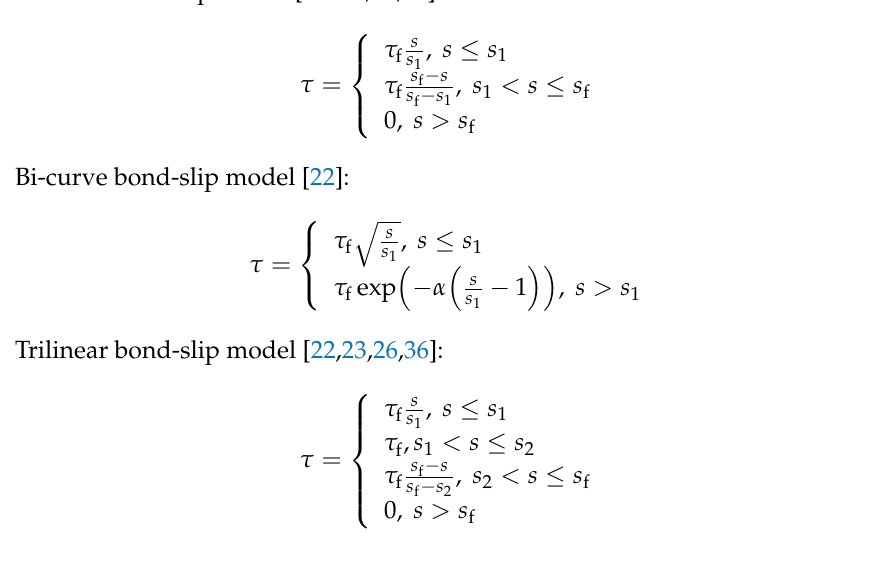
Figure 1. Two typical bond-slip curves of the bonding interface between CFRP materials and uncorroded steel substrates: ( a ) two-segment bond-slip curves; ( b ) three-segment bond-slip curves. As the bond-slip curves of the CFRP-steel bonding interface have been recorded as presenting different forms, several different types of bond-slip models [21,23,26,27,29] have been proposed by different researchers based on their respective test results. From the perspective of the structures, in terms of model expression, these models can be divided into four categories, namely, a bilinear model, a bi-curve model, a trilinear model, and a continuous model, as expressed in Equations (1)–(4), respectively. The bilinear model, bi-curve model, and continuous model have been regularly adopted to describe the aforementioned two-segment bond-slip curves, while the trilinear model has been adopted to describe the aforementioned three-segment bond-slip curves.